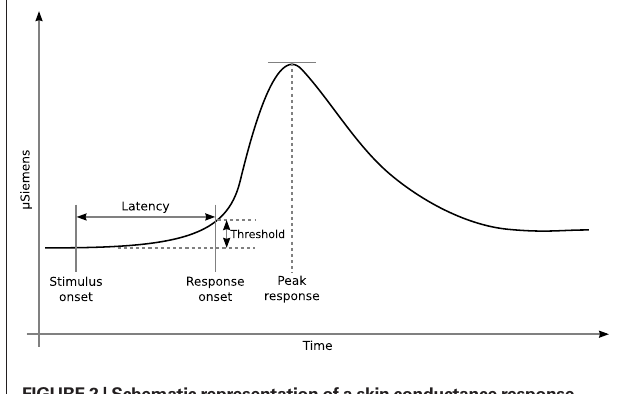
FigurE 2 | Schematic representation of a skin conductance response (SCr). The skin conductance level starts to increase after a few seconds following the stimulus onset, and this delay between the stimulus onset and the response onset is called the “latency.” From the results of two short tests taken at the beginning of the experiment, we extracted the value for the latency of each subject. In the data analysis for the main experiment, we calculated the stimulus onset time from the response onset detected and the known